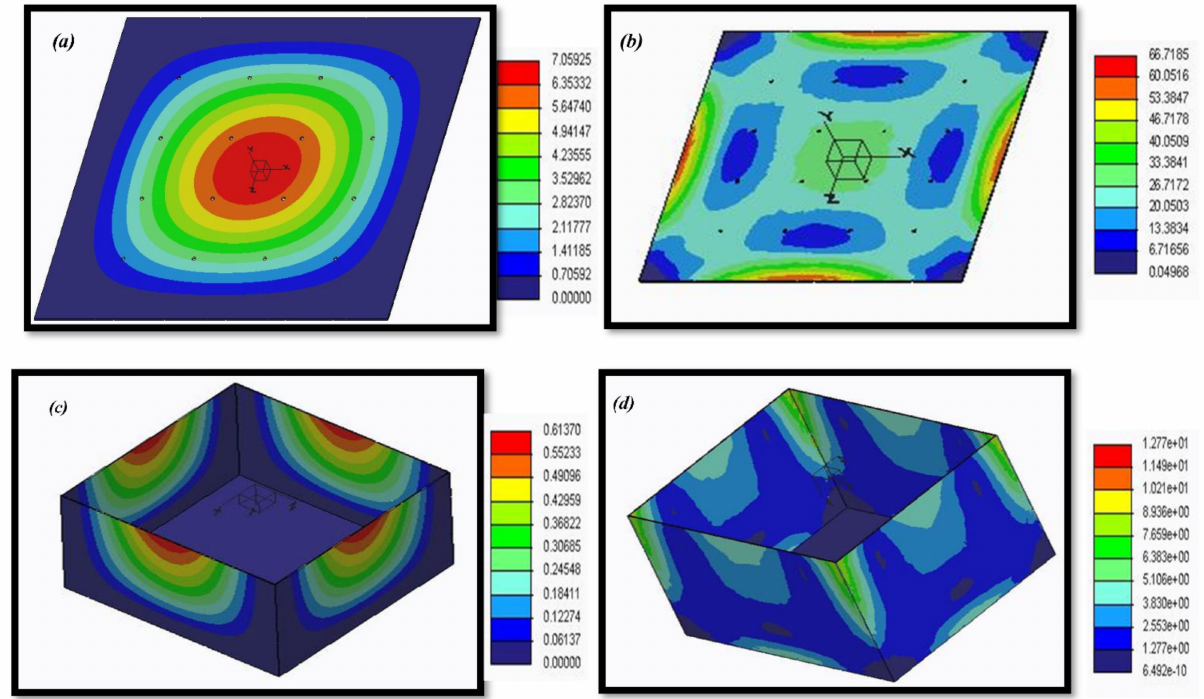
Figure 12. Three-dimensional view of the results obtained in load combination: ( a ) and ( c ) represent resulting displacement (mm), whereas ( b ) and ( d ) represent Von Mises equivalent stress (MPa) for the bottom perforated sheet and walls of the cultivation tank of the lysimeter,